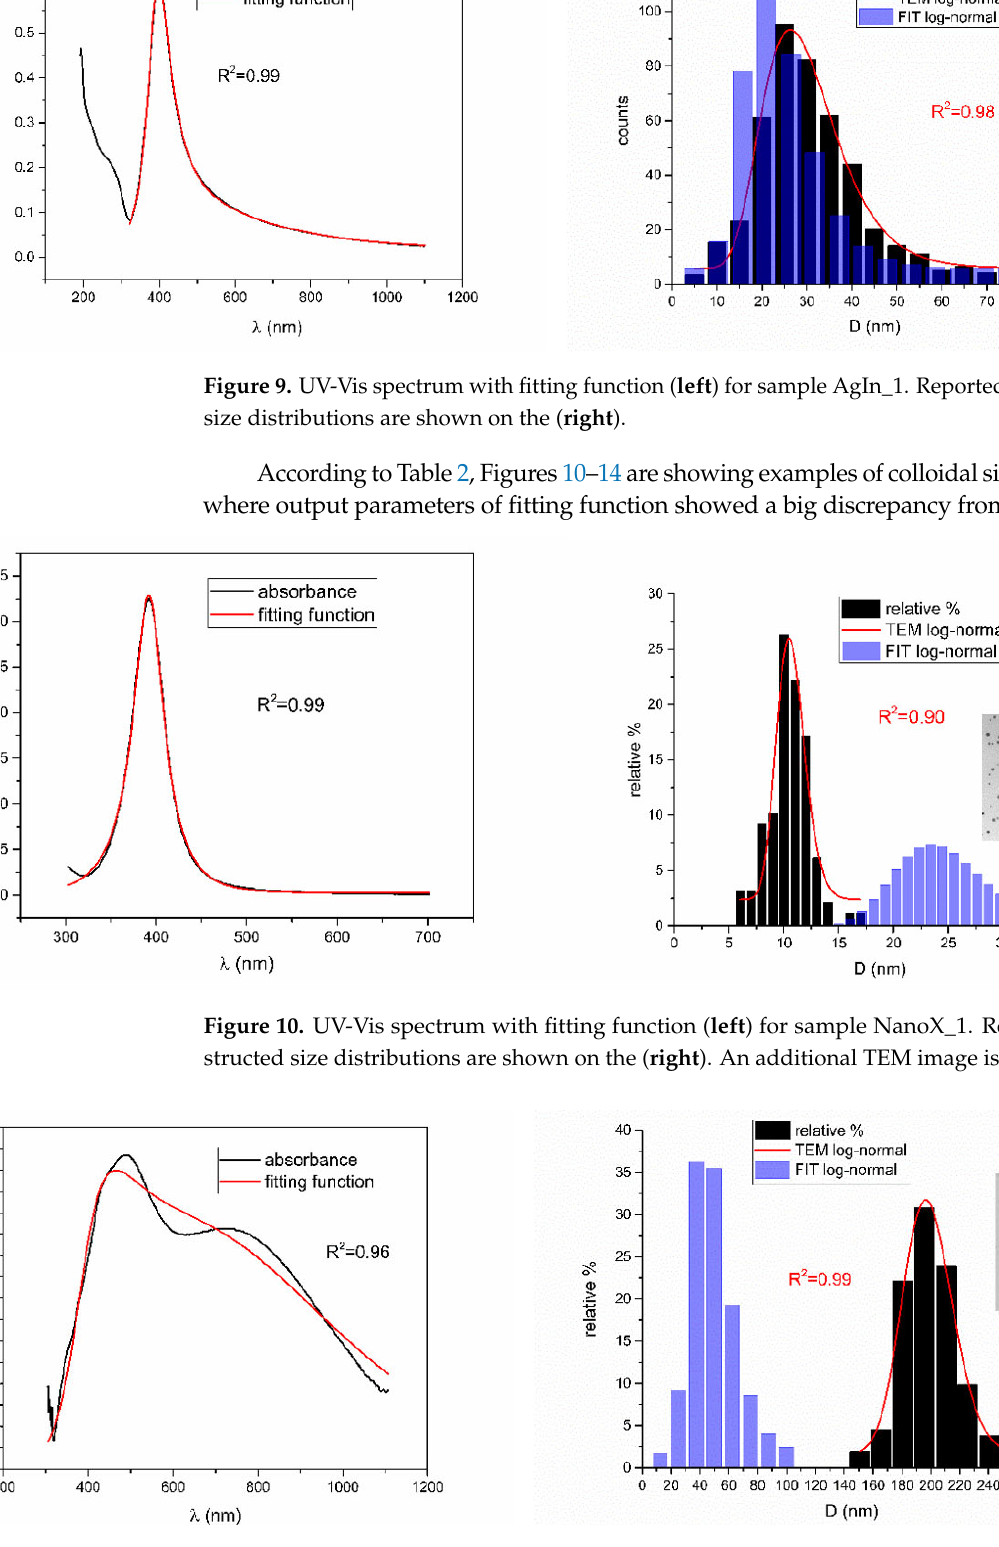
Figure 11. UV ‐ Vis spectrum with fitting function ( left ) for sample NanoX_10. Reported and recon ‐ structed size distributions are shown on the right . An additional TEM image is also shown.